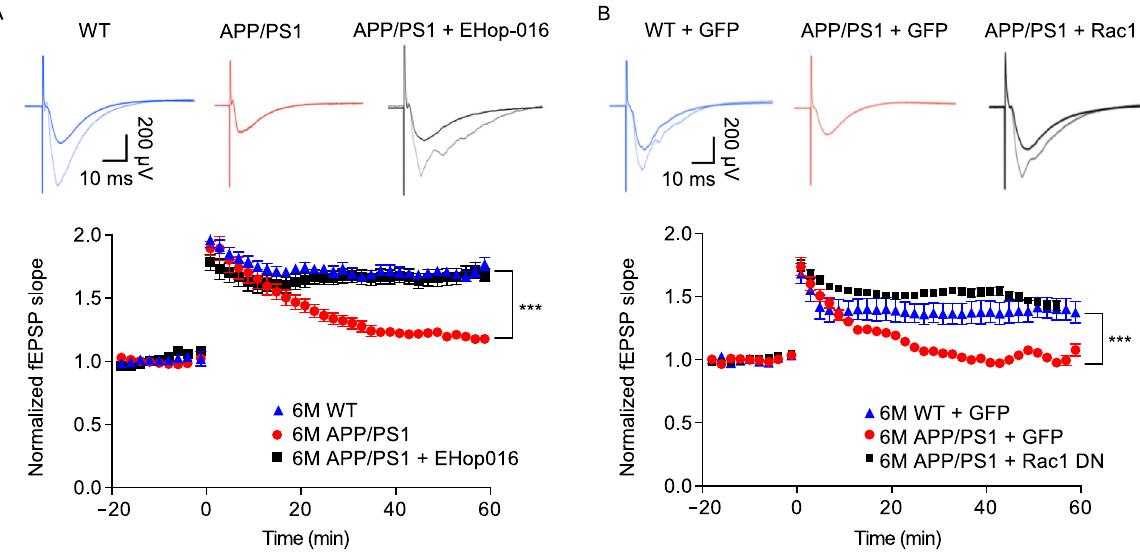
Figure 5. De fi cit of synaptic plasticity in APP/PS1 is ameliorated by inhibition of Rac1. (A) Representative example of evoked responses immediately before (solid line) and 30 min after (dashed line) induction of LTP (upper panel). De fi cit of LTP maintained in 6-month-old APP/PS1 mice was attenuated by EHop-016 (lower panel, *** P < 0.0001, two-way ANOVA followed by Tukey ’ s multiple comparison test, n = 14 for WT, n = 13 for APP/PS1, n = 13 for APP/PS1 + EHop-016). (B) Representative examples of evoked responses immediately before (solid line) and 30 min after (dashed line) induction of LTP (upper panel). De fi cit of LTP maintained in 6-month-old APP/PS1-GFP mice was rescued by expression of Rac1 DN in the hippocampus (lower panel, *** P < 0.0001,